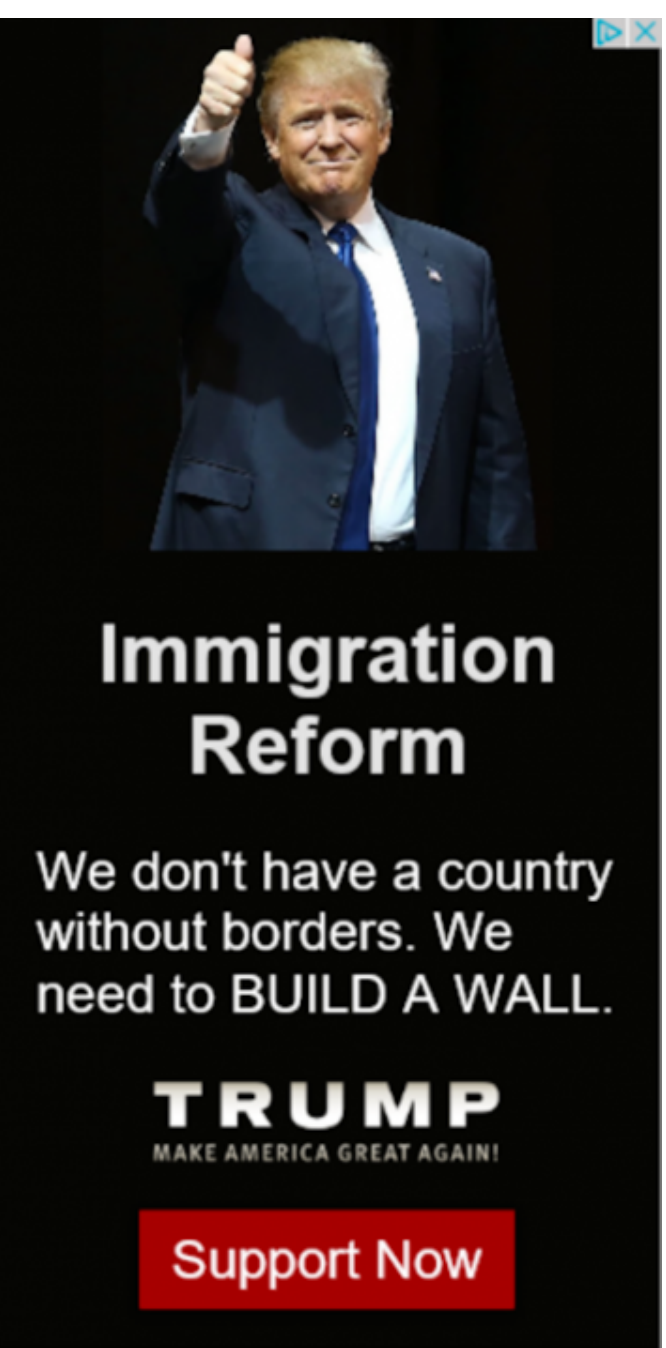
Figure 4: Donald Trump digital advertisement Source: Democracy in